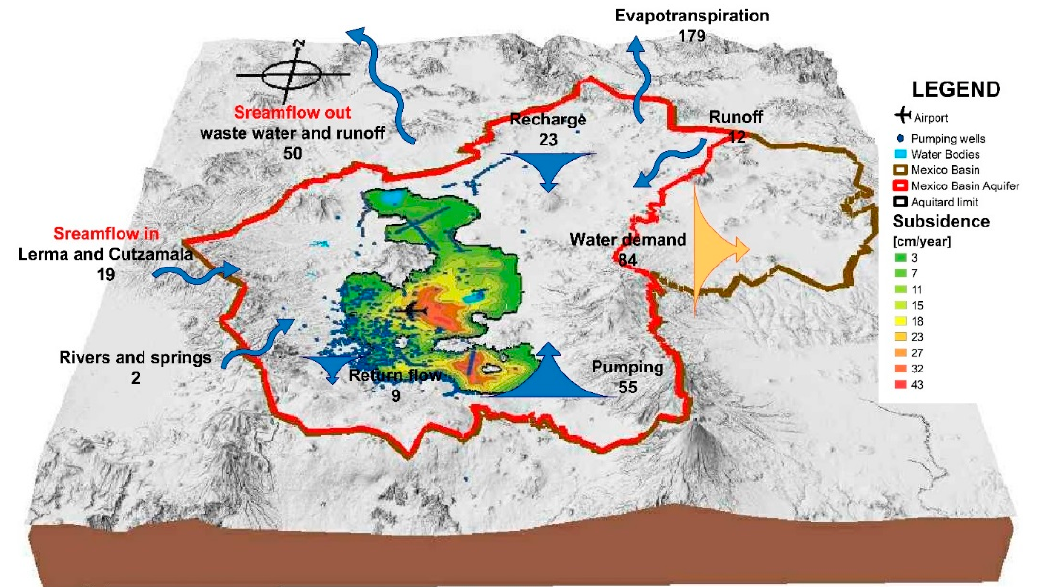
Figure 5. Water budget of the Mexico Basin in cubic meters per second in 2019. Land subsidence rates on aquitard, from 1999–2008, modified from [20].